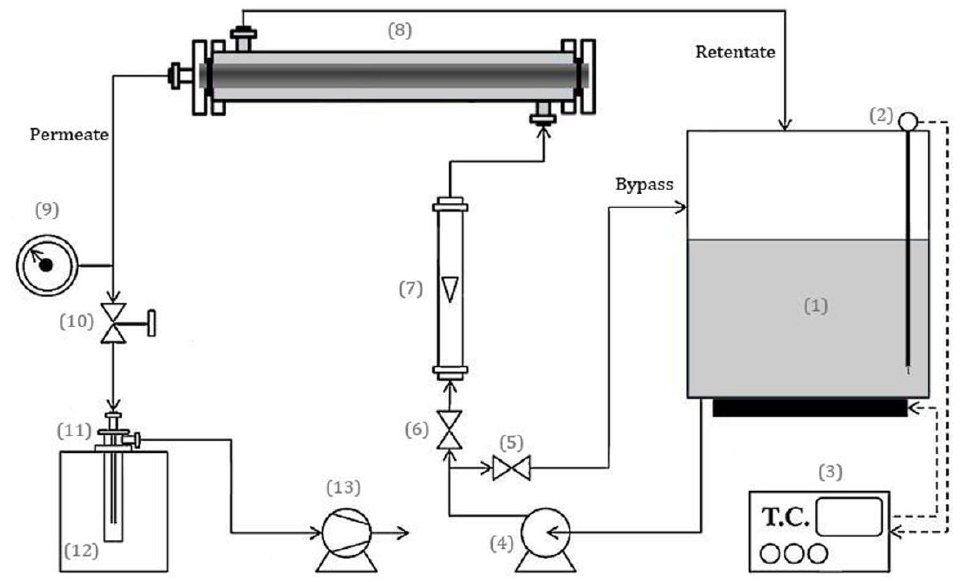
Figure 1. The schematic diagram of laboratory pervaporation set-up: ( 1 ) feed tank; ( 2 ) thermometer; ( 3 ) temperature controller; ( 4 ) feed pump; ( 5 , 6 ) Valve; ( 7 ) rotameter; ( 8 ) membrane module; ( 9 ) pressure gage; ( 10 ) vacuum regulator; ( 11 ) permeate collection trap; ( 12 ) liquid nitrogen tank; ( 13 ) vacuum pump.